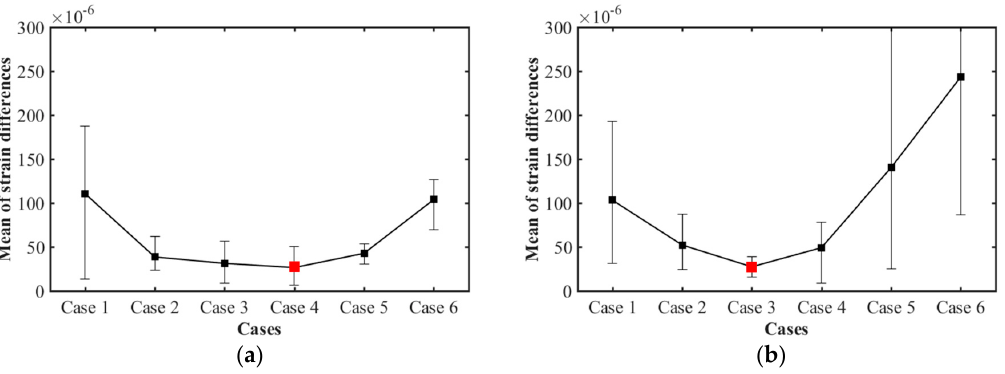
Figure 19. Mean of the strain differences for cases 1–6 between measured strain values of the ESGs, and the calculated values from the finite element models: ( a ) The mean of the strain differences in the vertical direction; and ( b ) Horizontal direction.